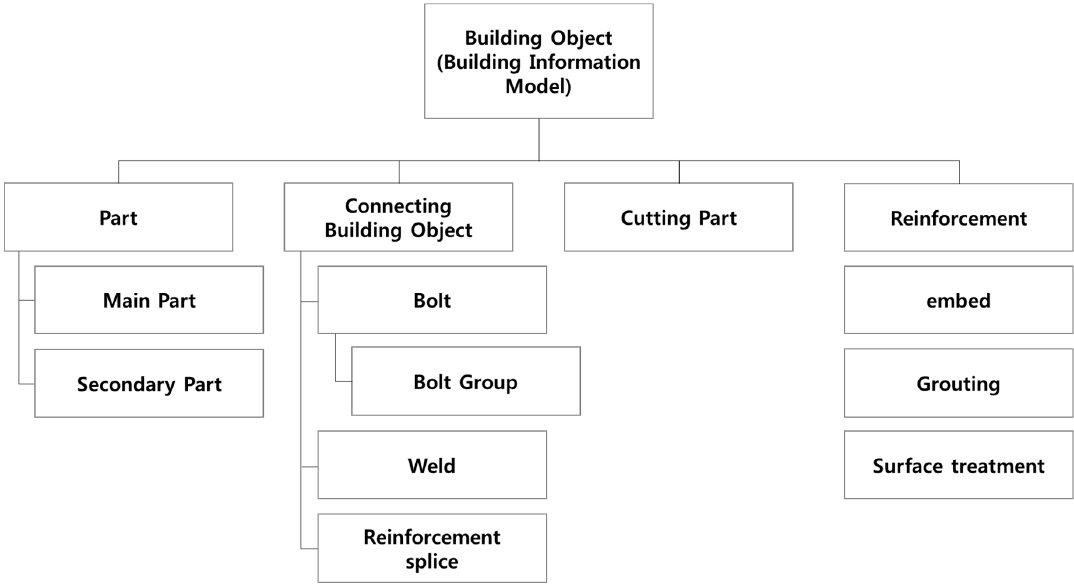
Figure 2. Building objects of the BIM model [69]. Table 5. Connecting building objects to create a prefabricated steel frame.